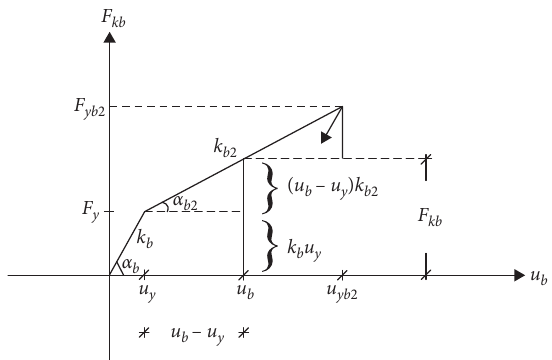
Figure 2: Illustration of the hysteresis loop of the LCRB isolator and its geometric ratios